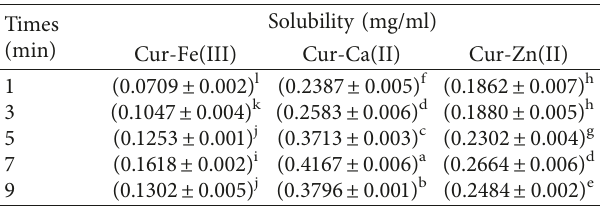
Figure 5: The effect of ultrasonic capacity on the dissolution of the curcumin metal complex. Table 4: Solubility of the complex in the water at different ul- trasound wave